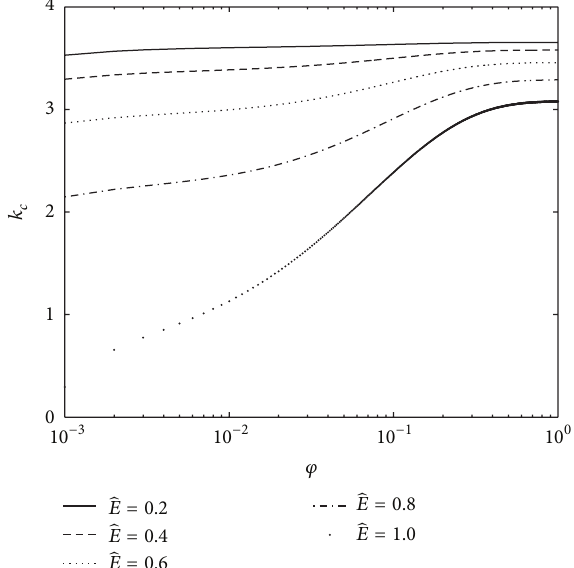
Figure 2: Neutral curves for critical wave number when 0.1 for the different values of heat transfer coefficient Λ .